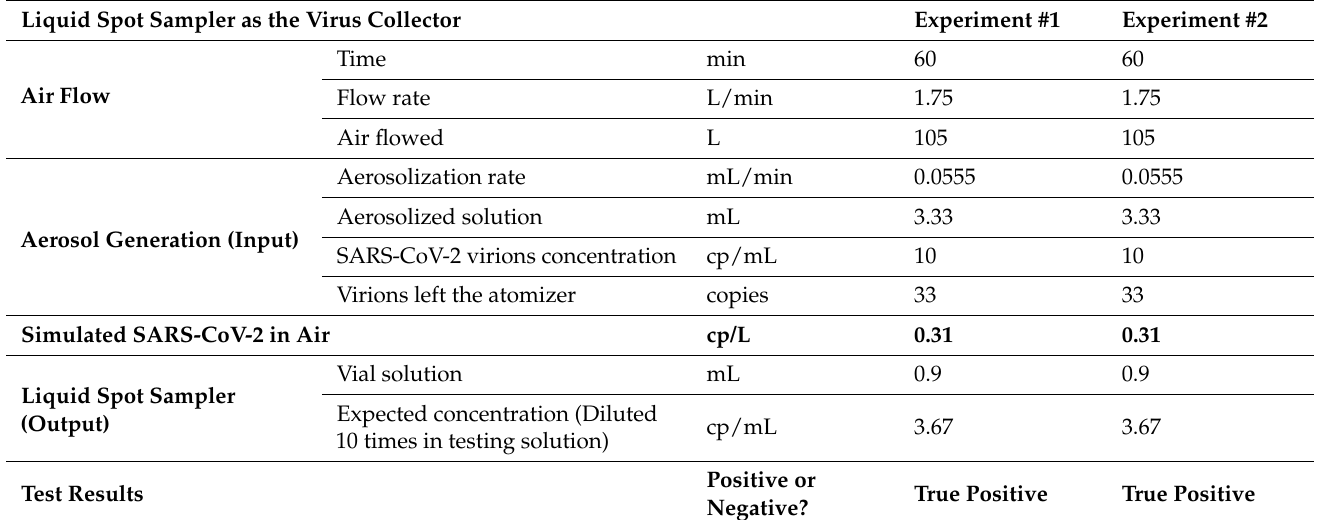
Figure 10. Chronoamperometry graph of the collected aqueous samples (3.67 cp/mL of SARS-CoV-2 virions) from two repeated air sampling experiments ( a , b ) using the test rig with TSI Atomizer and Liquid Spot Sampler. The current at 0.001 s of the collected samples is more than 2% higher than the baseline current indicating the samples are Positive. Table 1. Simulated air sensing with TSI atomizer and collection with the Liquid Spot